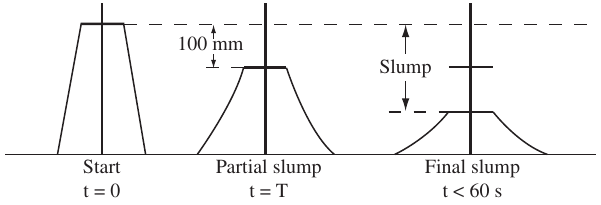
Figure 2. Scheme of the modified slump test 13 .